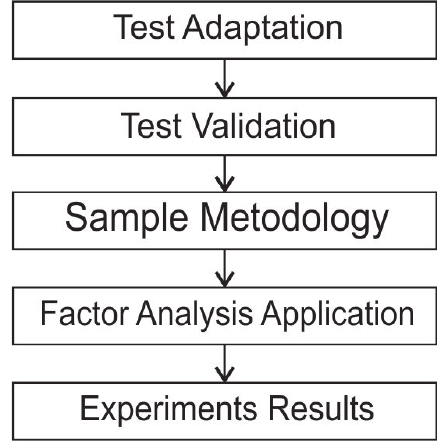
Figure 1. Methodology to carry out the